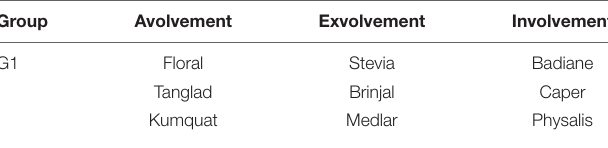
TABLE 2 | Emotioncy